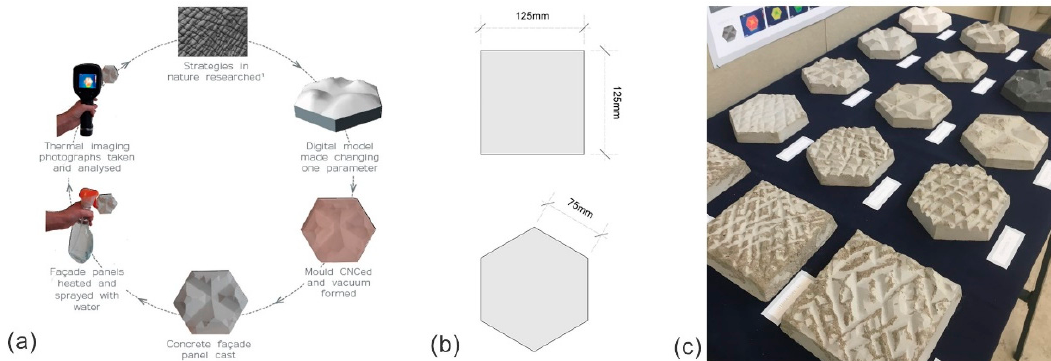
Figure 2. ( a ) Experiment process—studying morphology from nature, constructing a digital model, creating the physical model using CNC, forming a mold using vacuum forming around the physical model, casting a concrete panel in the mold, heating panels, spraying with water, taking thermal images over 30 min; ( b ) sample size—all of the sample panels have the same perimeter dimensions, dependent on their shape; ( c ) Photograph of the resultant textured panels for the various investigations.